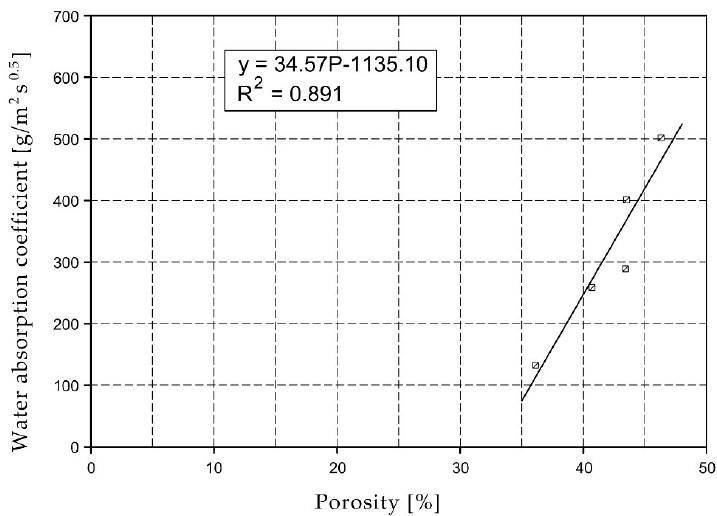
Figure 8. Compressive strength of O04XX series bricks.